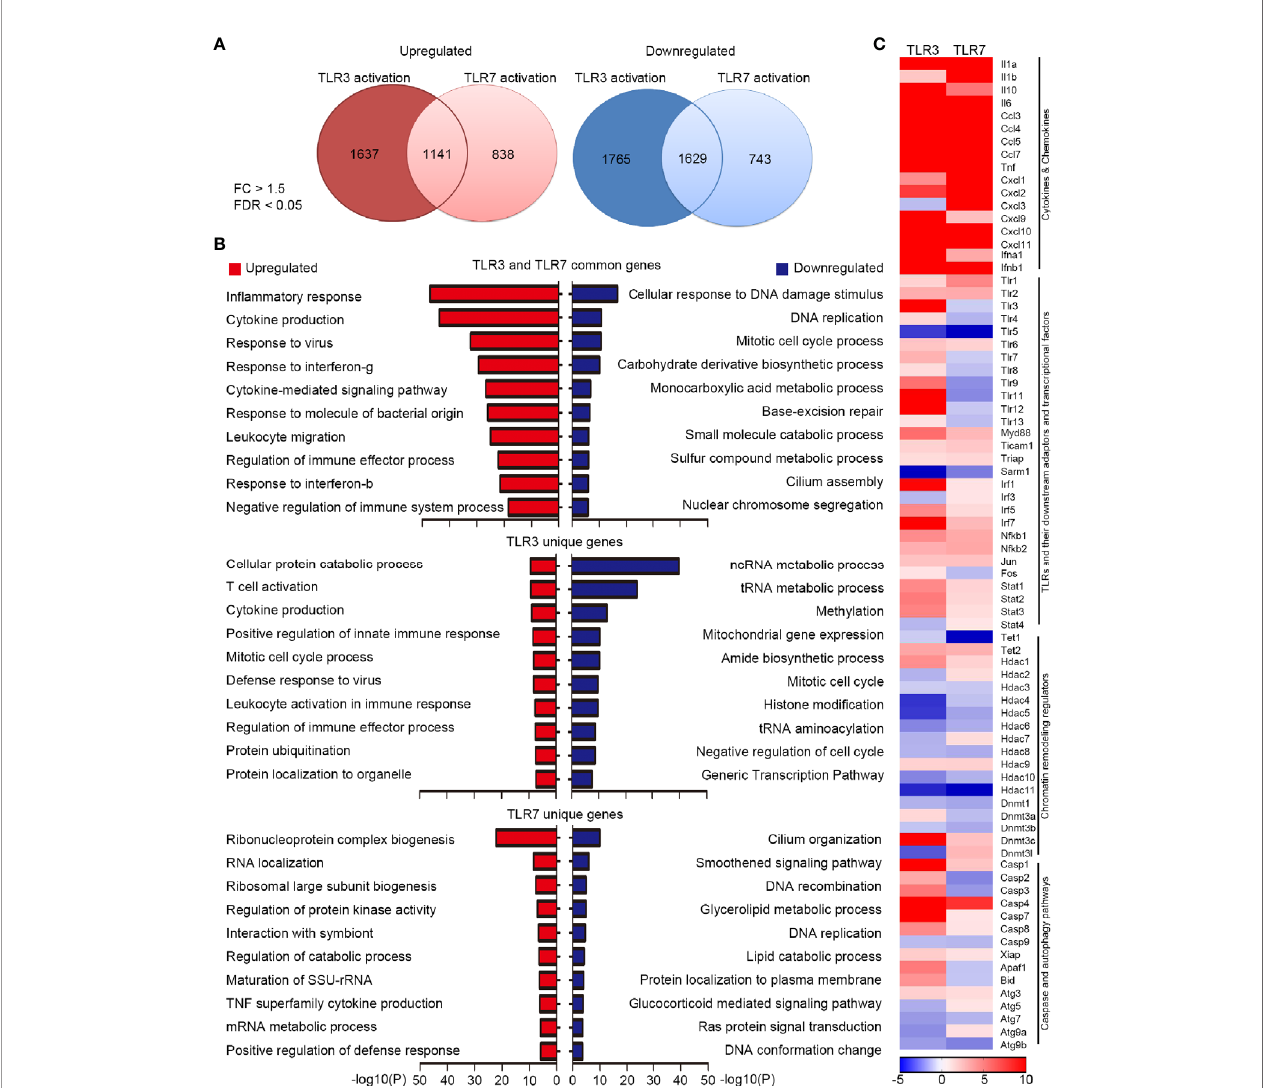
FIGURE 1 | Transcriptomic pro fi ling reveals differential downstream targets of TLR3 and TLR7 in BMDMs. (A) Venn diagram showing the overlap and difference between TLR3- and TLR7-regulated genes. Left: upregulated; Right: downregulated. Fold change (FC) > 1.5; false discovery rate (FDR) < 0.05. The numbers of identi fi ed genes are also indicated. (B) Gene ontology (GO) of commonly-targeted or uniquely-targeted TLR3 and TLR7 genes based on biological functions. Red bars: upregulated genes; blue bars: downregulated genes. The top ten GOs for each group are shown. (C) Heat map depicting the relative mRNA levels of selected TLR3- and TLR7-regulated genes. Scale bar: